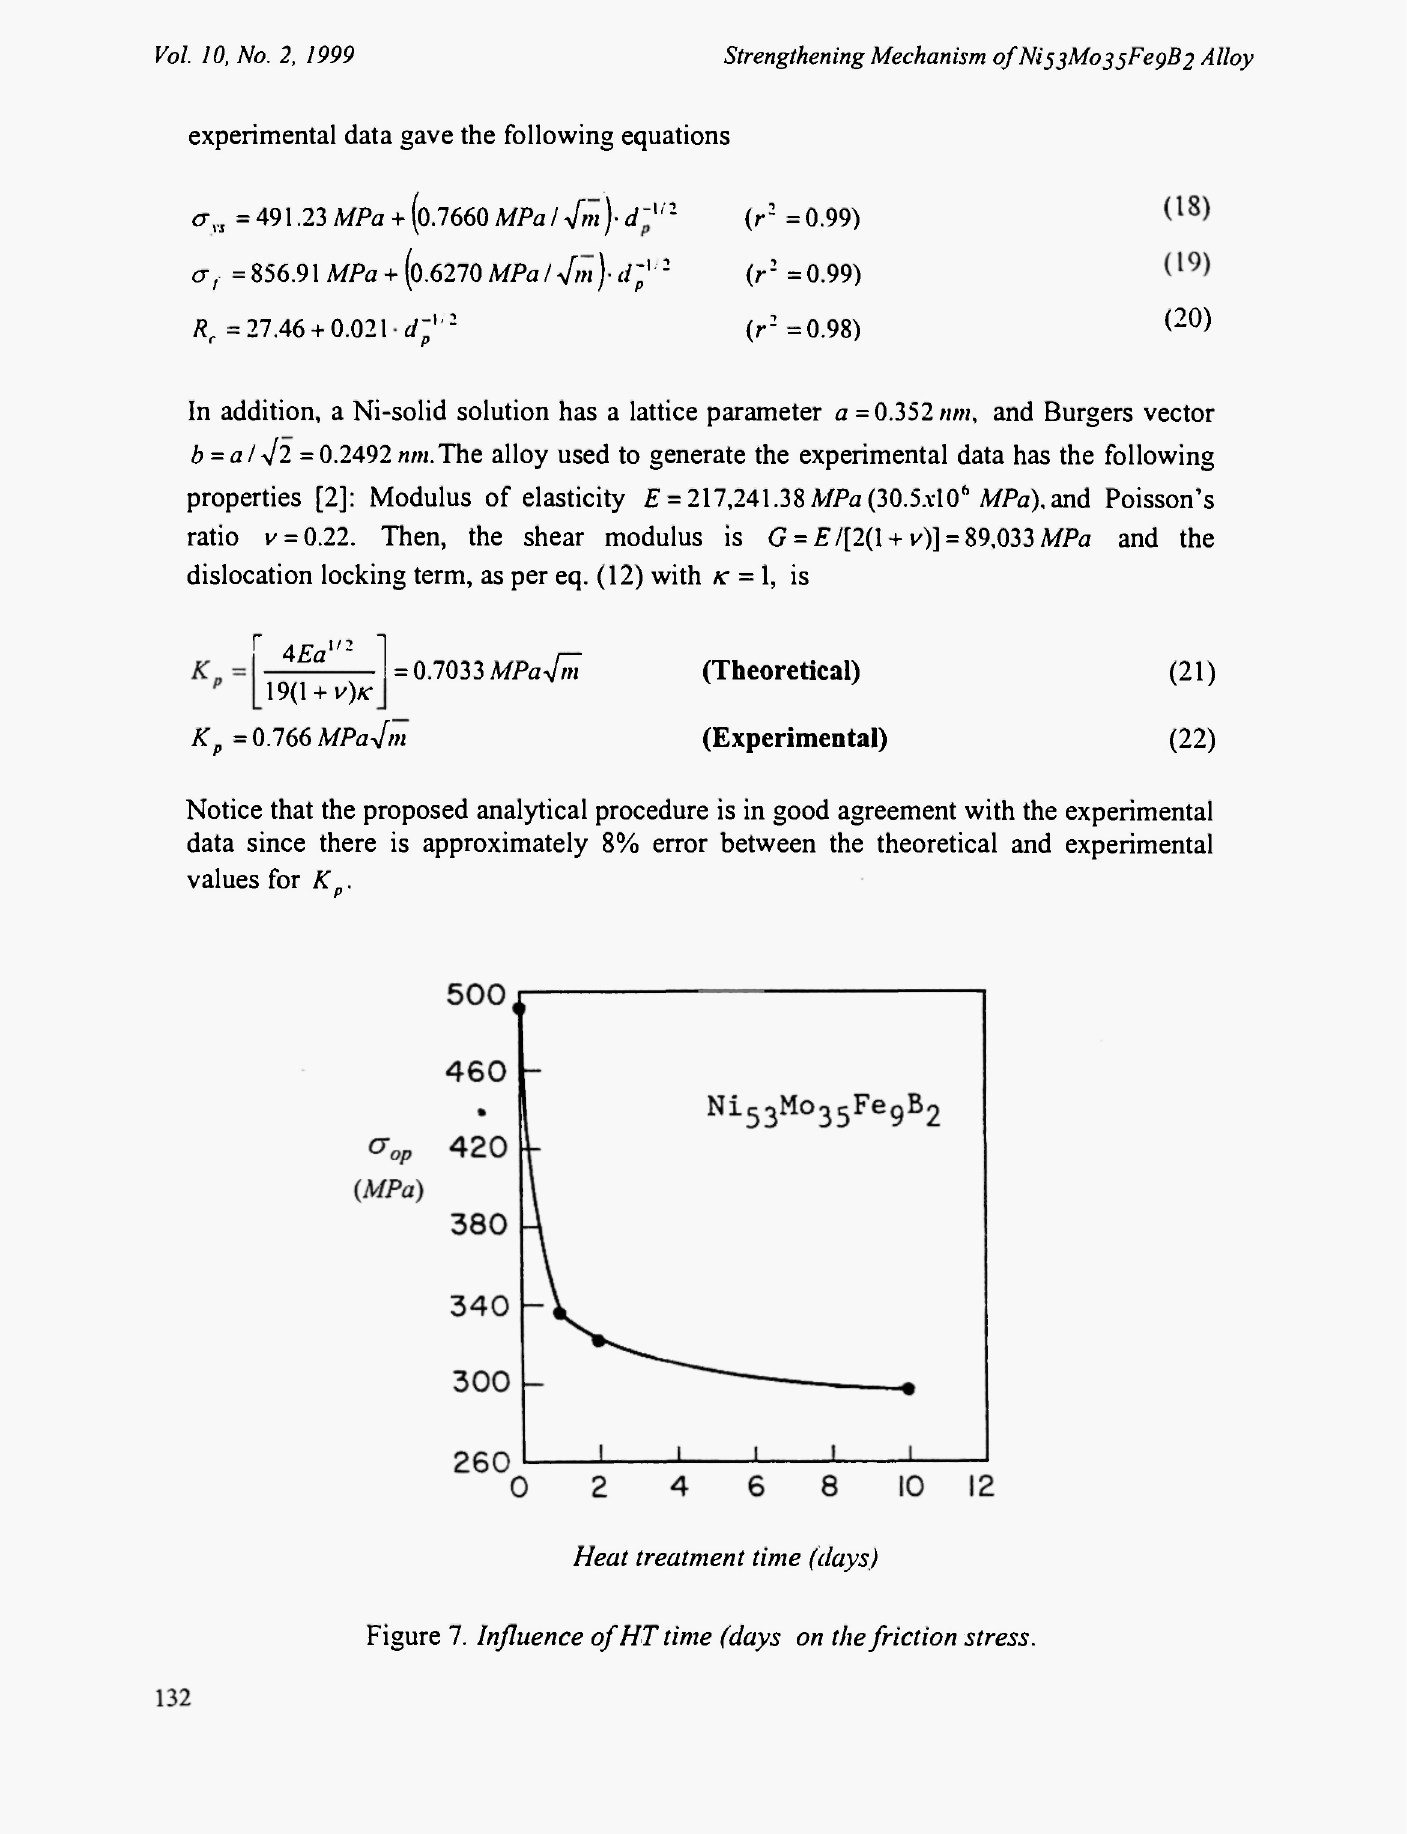
Figure 7. Influence of HT time (days on the friction